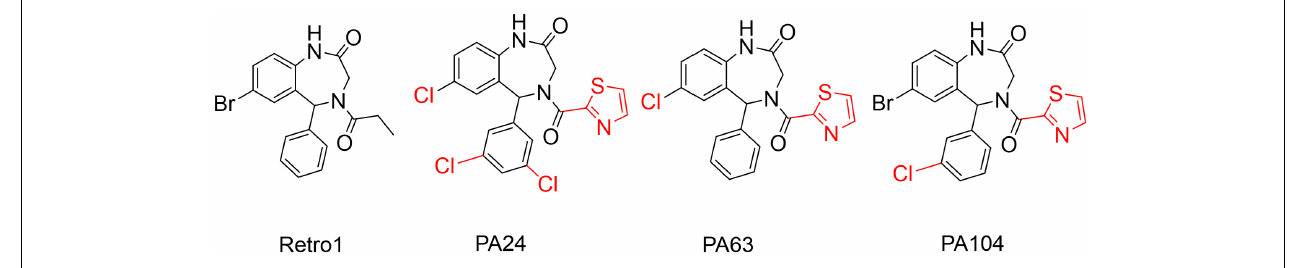
FIGURE 6 | Structural modifications in PA104, PA24, and PA63. All modifications made to the original Retro-1 structure shown in red.